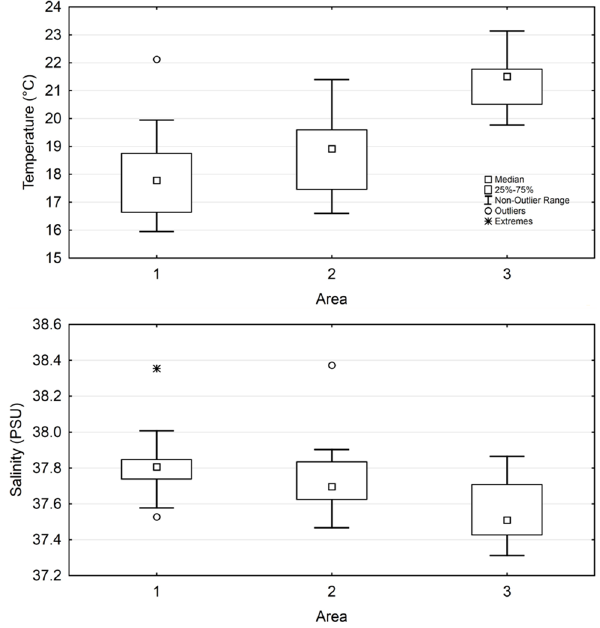
Figure 4. Box plot of temperature and salinity in the layer 5–30m for the upwelling areas (1 and 2) and the control area (3), identified in Fig.